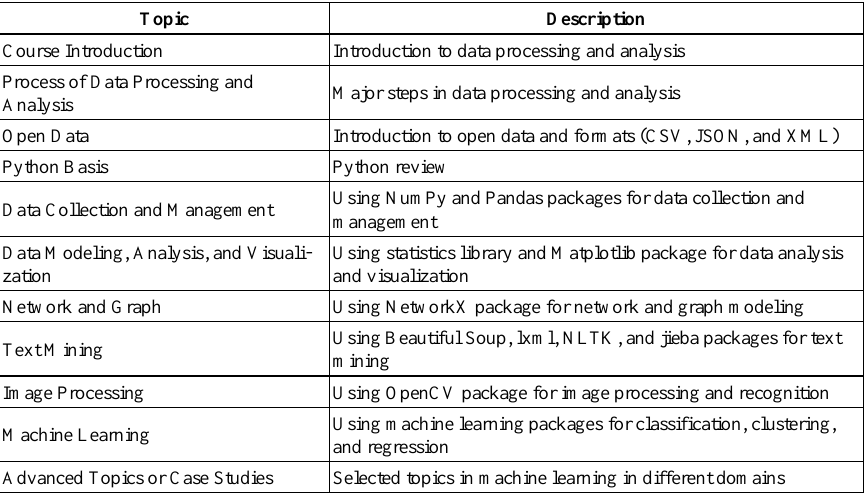
Table 3. Syllabus of data processing and